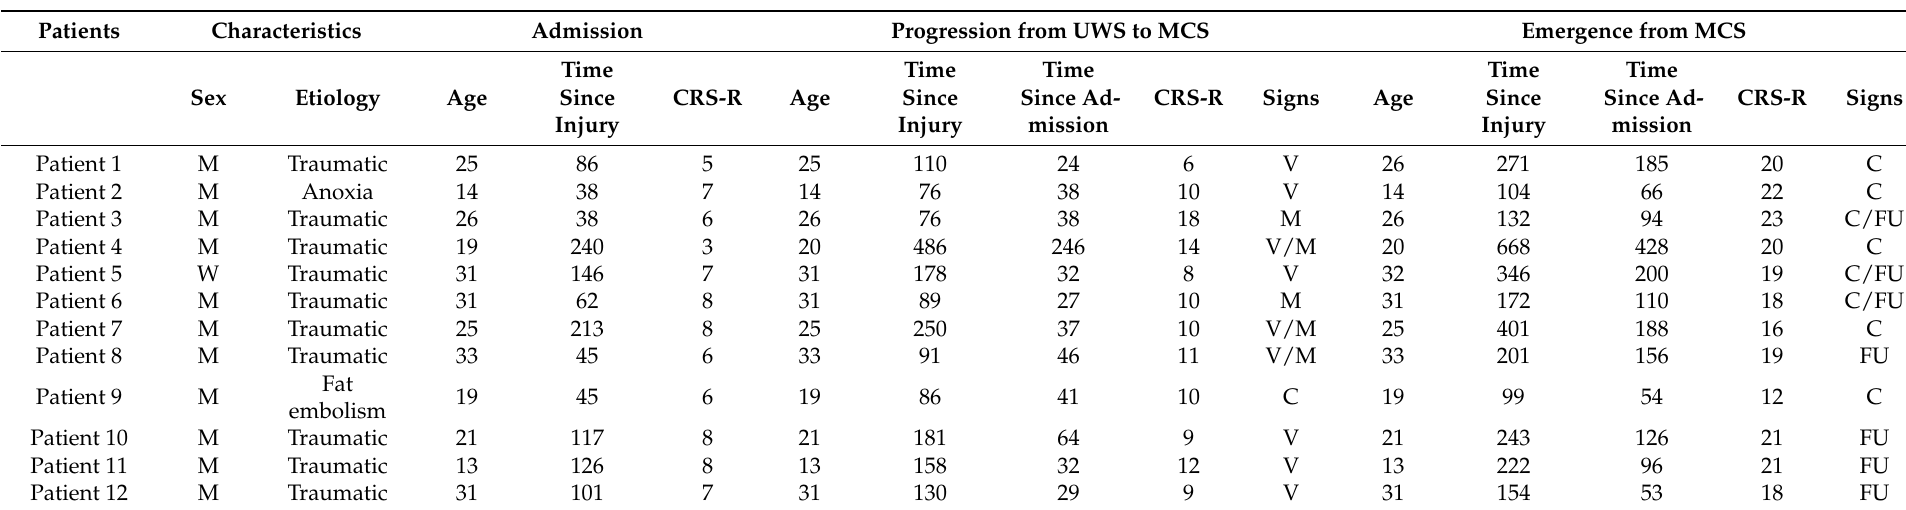
Table 3. Individual characteristics and neurobehavioral progress until emergence from the minimally conscious